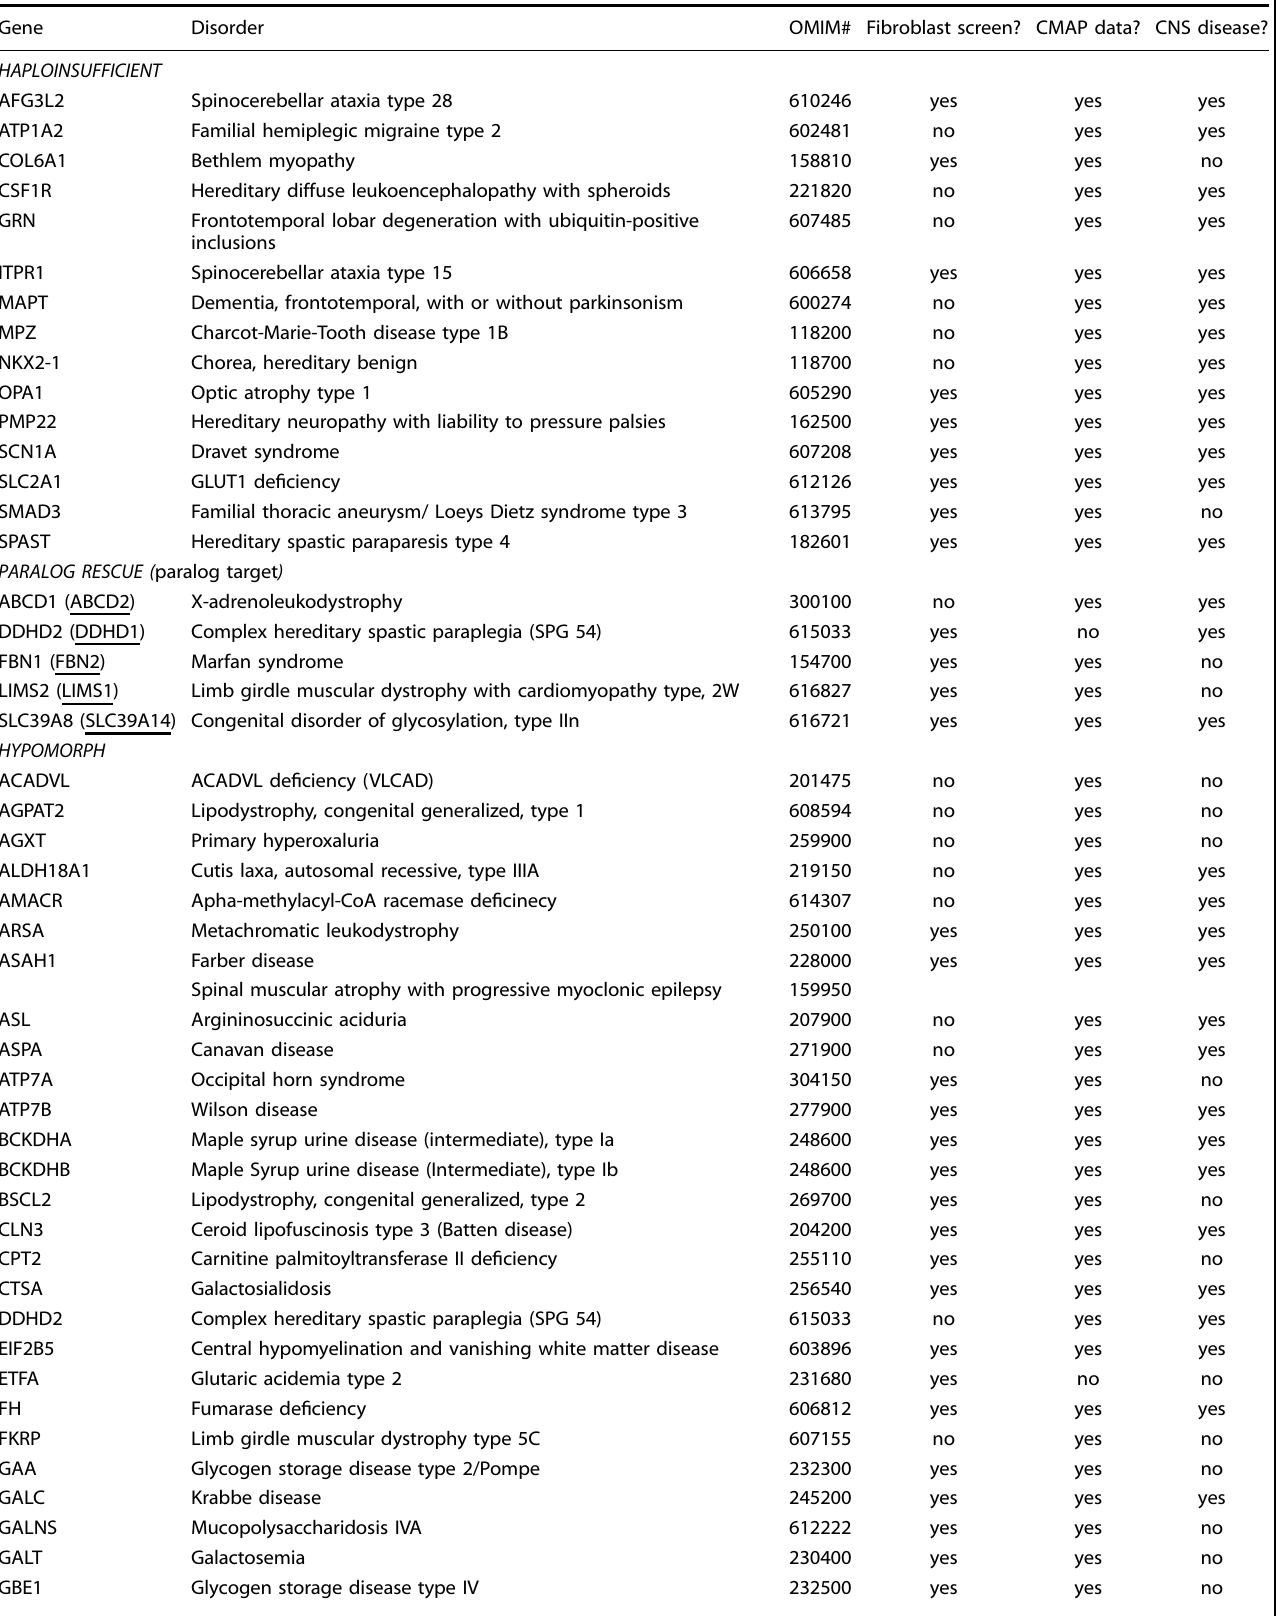
Table 1. The 76 diseases and associated 75 genes analyzed in this study (classi fi ed as haploinsuf fi cient; paralog rescue, or hypomorph categories) Gene